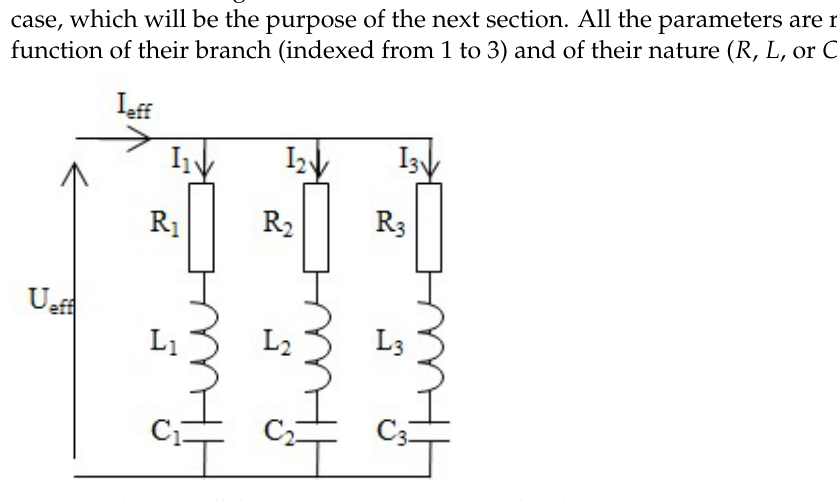
Figure 5. Three parallel RLC branches’ circuit